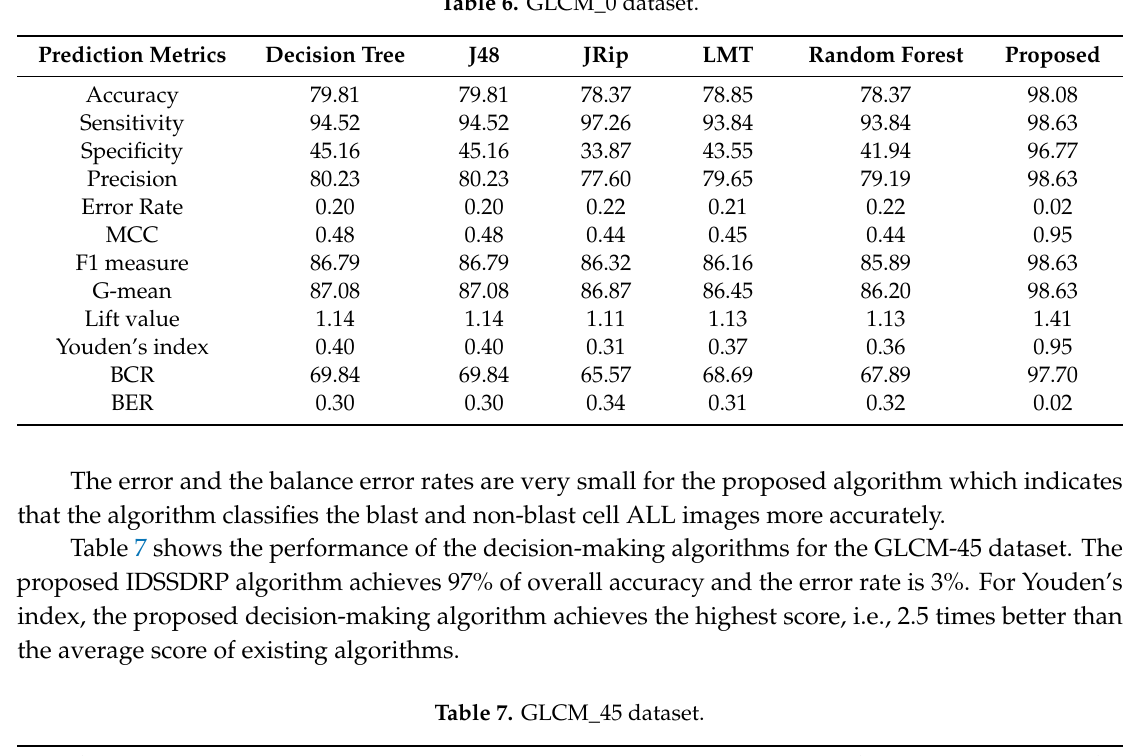
Table 6. GLCM_0 dataset.